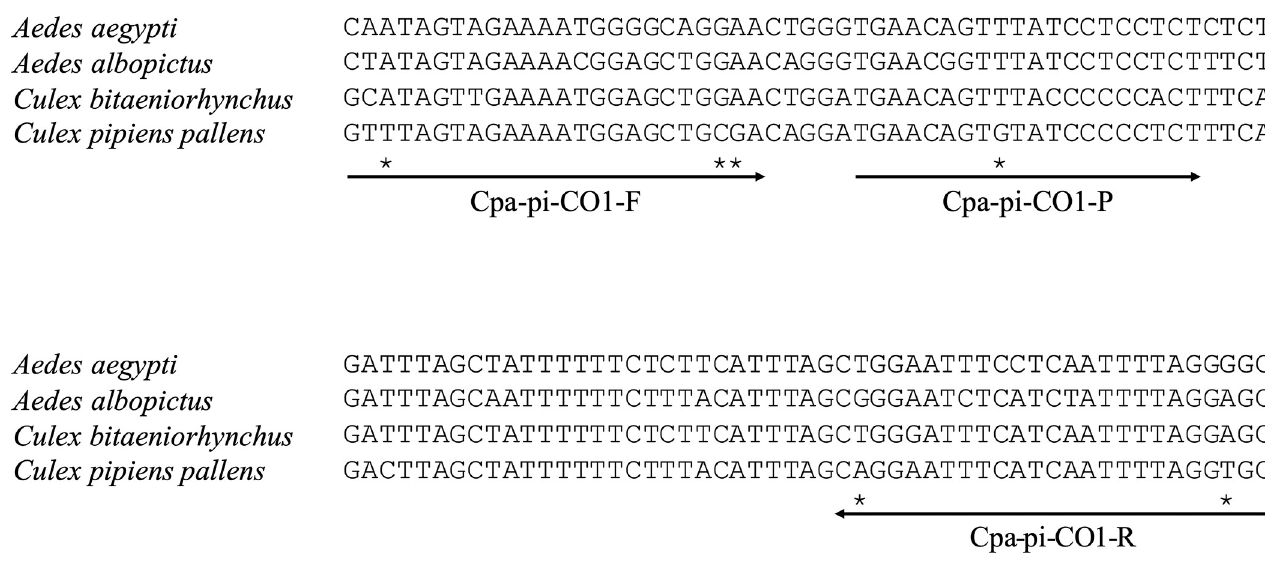
Fig 1. Alignment of the amplified region of mitochondrial CO1 gene of C . pipiens pallens and closely related, potentially sympatrically distributed species with C . pipiens pallens in Japan. Asterisks indicate C . pipiens pallens -specific nucleotides. The length of the amplicons was 136 bp.